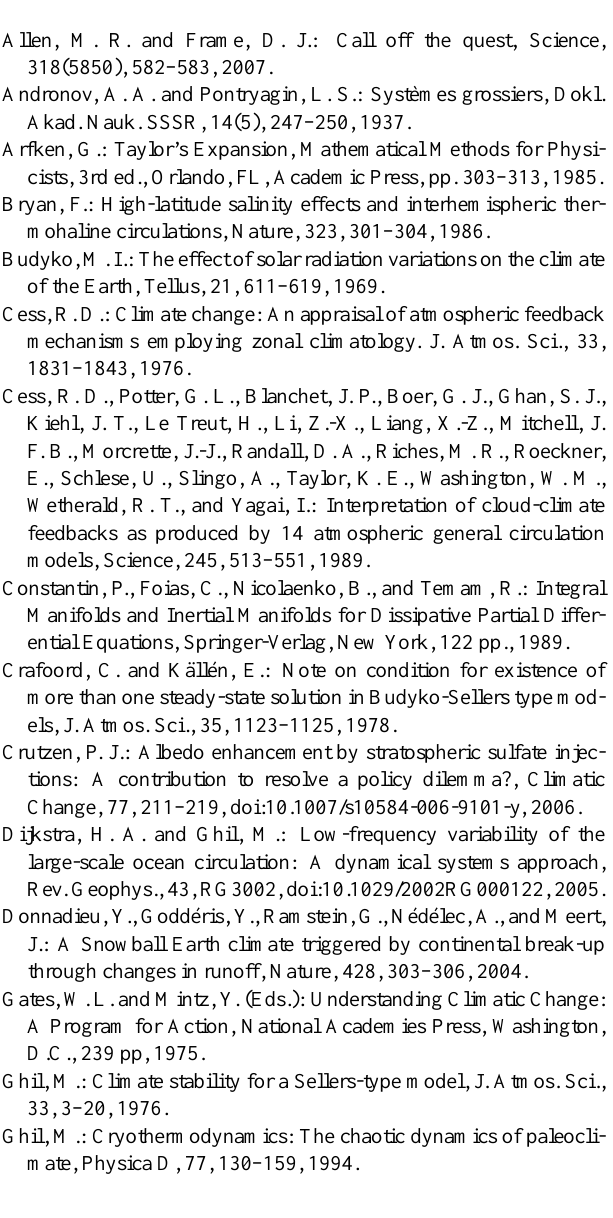
Fig. 4. Outgoing radiation 𝑅 o (red, dashed line) and absorbed in- coming solar radiation 𝑅 i (blue, solid lines) for our 0-D energy- balance model (EBM), governed by Eq. (15). The absorbed radia- tion is shown for 𝜇 = 0 . 5 , 1 and 2.0 (from bottom to top), while 𝜅 = 0 . 05 . Notice the existence of one or three intersection points on the between the 𝑅 o curve and one of the 𝑅 i curves, depending value of 𝜇 ; these points correspond to the equilibrium solutions of (15), i.e. to steady-state climates.